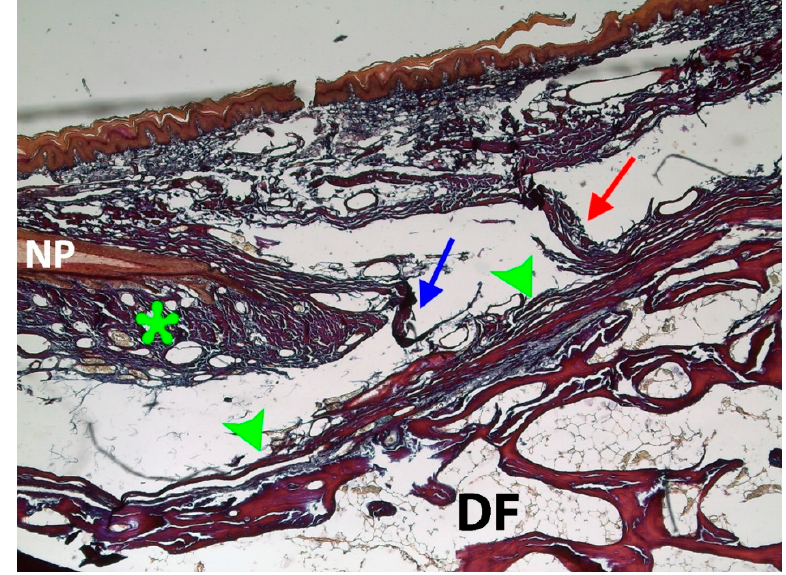
Figure 7. High-power magnification of the yellow squared area of Figure 6. Detail of the superficial fibers of the EPL bundles (blue and red arrows) attached at the base of ventral matrix (asterisk) to the underlying distal phalanx (DF) bone, crossing the deep fibers of the extensor pollicis longus tendon (EPLT) bundles (green arrowheads). Superficial fibers of the EPL tendon expansion to the eponychium (blue and red arrow), which run distally along the complete dorsal aspect of the distal phalanx, until its end (20× magnification). Tetrachrome VOF-III GS stain (light green SF/or fast green FCF, methyl blue, Orange G, and acid fuchsin).